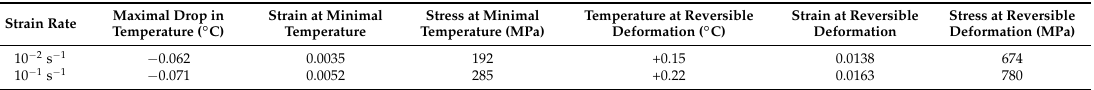
Table 3. Comparison of estimated values of characteristic deformation stages (Figure